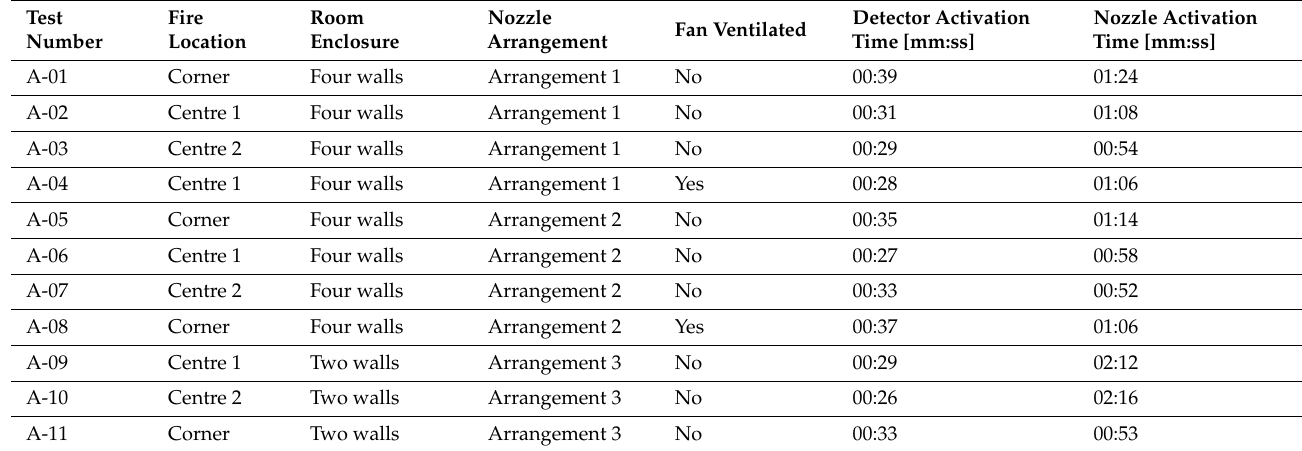
Table 2. A summary of the 11 test arrangements and nozzle activation times.